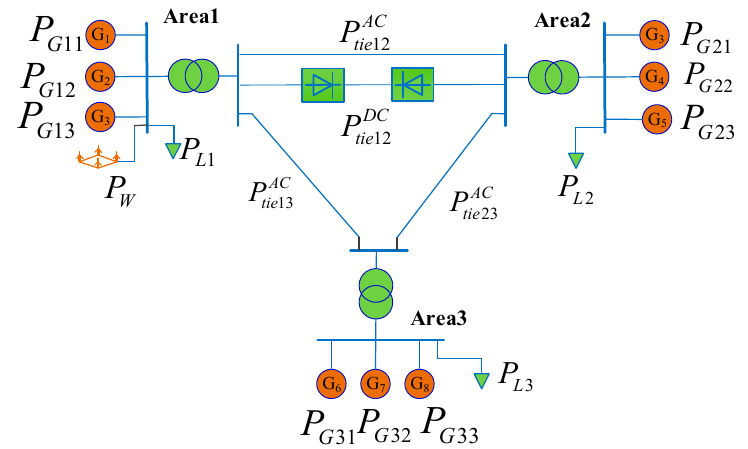
Figure 5. Three-area AC / DC interconnected power grid with wind